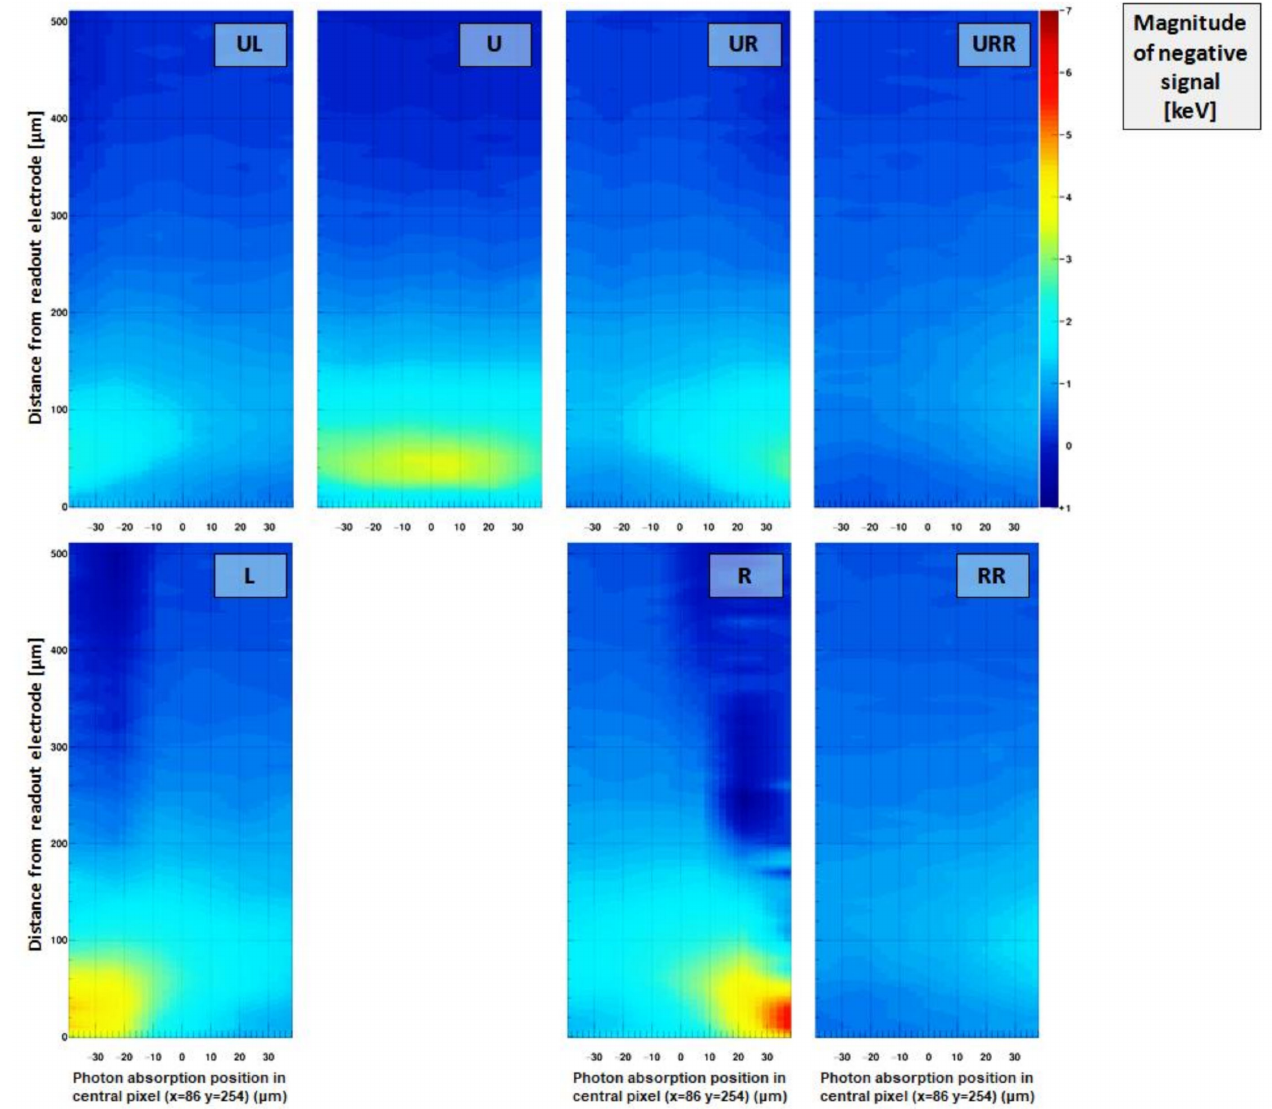
Figure 16. Intensity of the negative signal induced in pixels surrounding the pixel under investigation. The direct neighboring pixels (L/U/R) show negative signals which on average reach around –10% or –4 keV of the incoming photon energy of 40 keV. The diagonal neighboring pixels (UL/UR) still exhibit negative signals down to around –5% or –2 keV. Even pixels further distant (RR/URR) show slightly negative mean values. It is obvious that the negative signal in the adjacent pixels is caused by photons absorbed close to the readout electrode, validating the assumptions previously made in the paper. Please note: Compared to Figure 14, where the pixel response is shown as function of the absorption position in the pixel itself, this plot indicates the pixel response of a pixel in the vicinity of the irradiated pixel as function of the absorption position within the pixel which is being